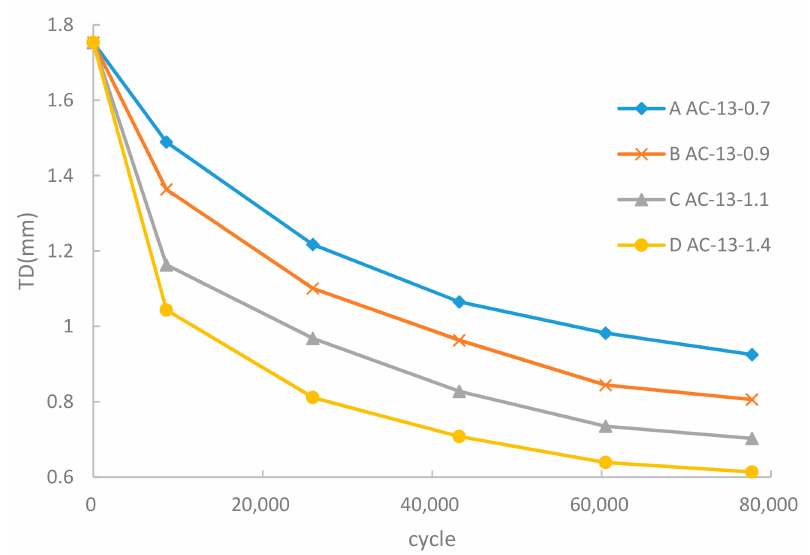
Figure 7. Heavy load e ff ect on TD.